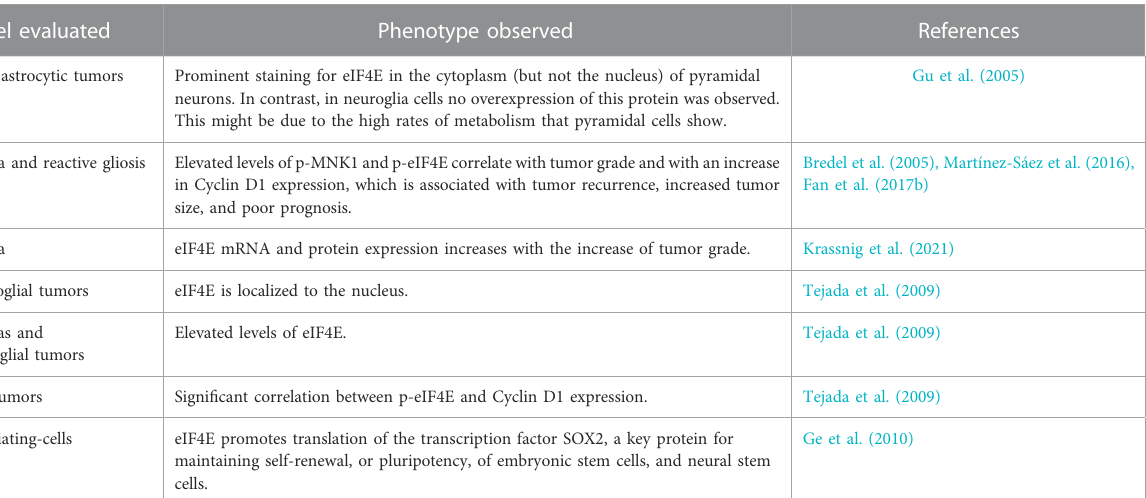
TABLE 1 eIF4E involvement in the development of brain